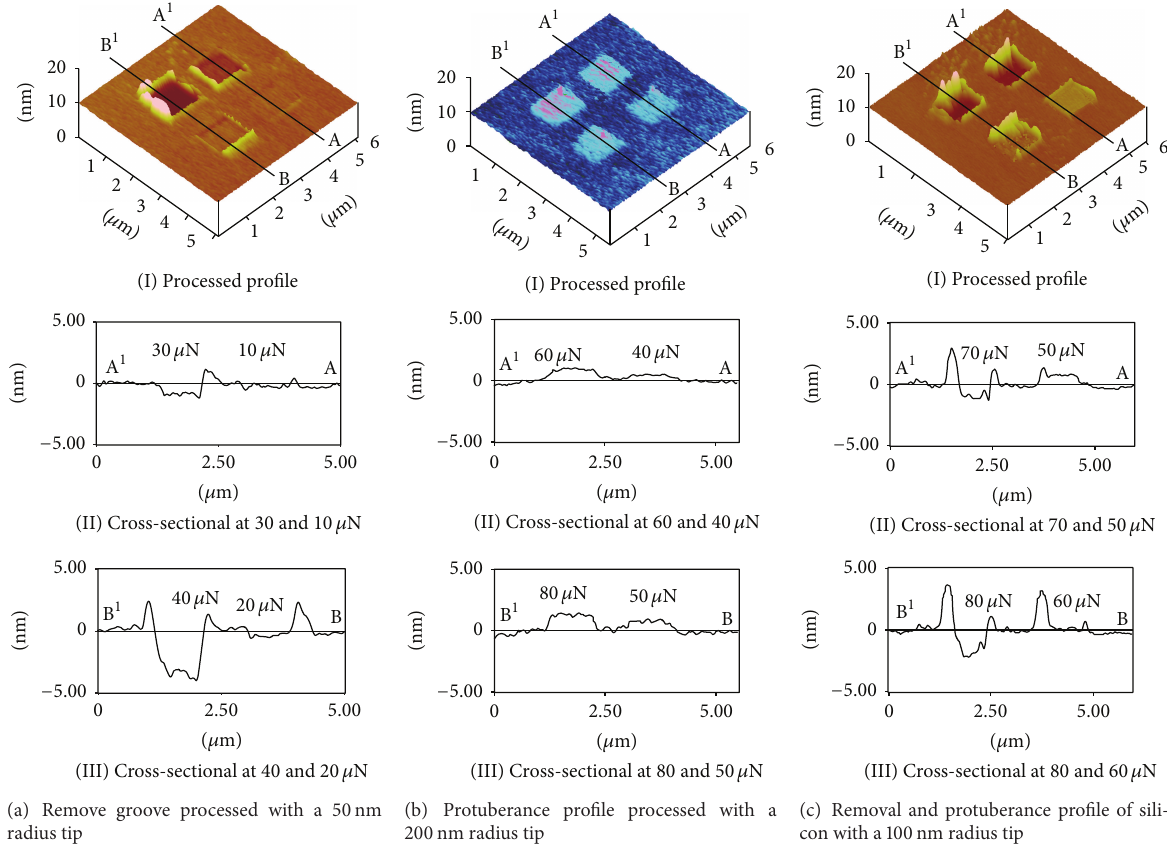
Figure 2: AFM profiles of silicon square areas processed by diamond tip sliding for different tip radii. (a) 50, (b) 200, and (c) 100 nm.